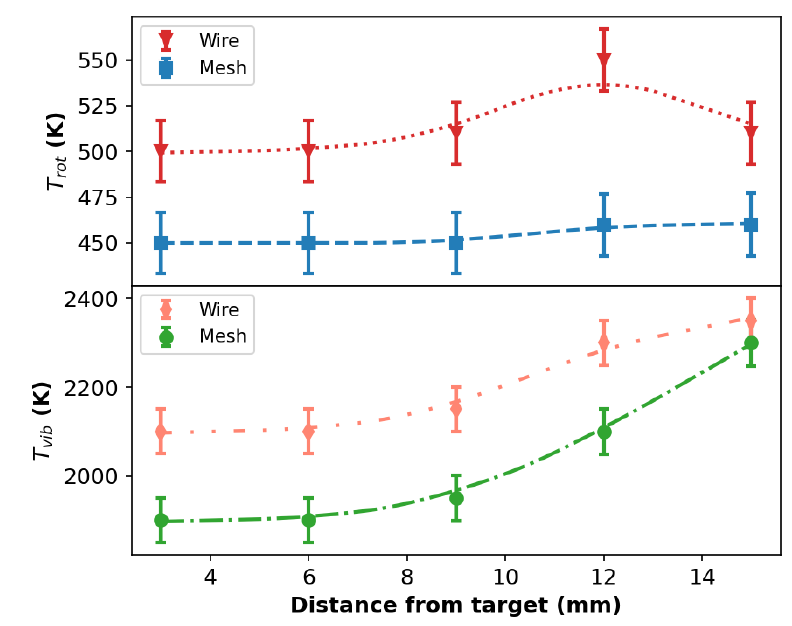
Figure 6. Rotational and vibrational temperatures as a function of the distance from target for both wire and mesh configurations with the APPJ impinging a glass target. The Ar flow rate was 2.0